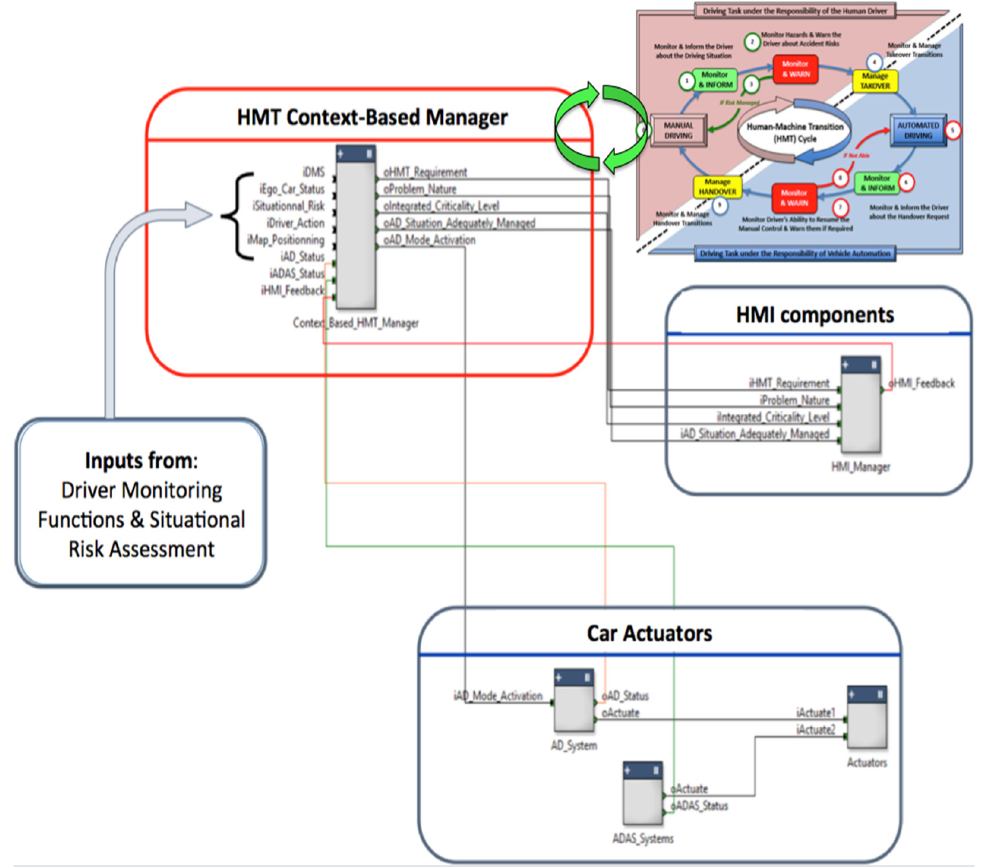
Figure 6. The HMT Manager as implemented with the RT-Maps software of Intempora © From the outputs generated by the HMT manager, the HMI components (i.e.,